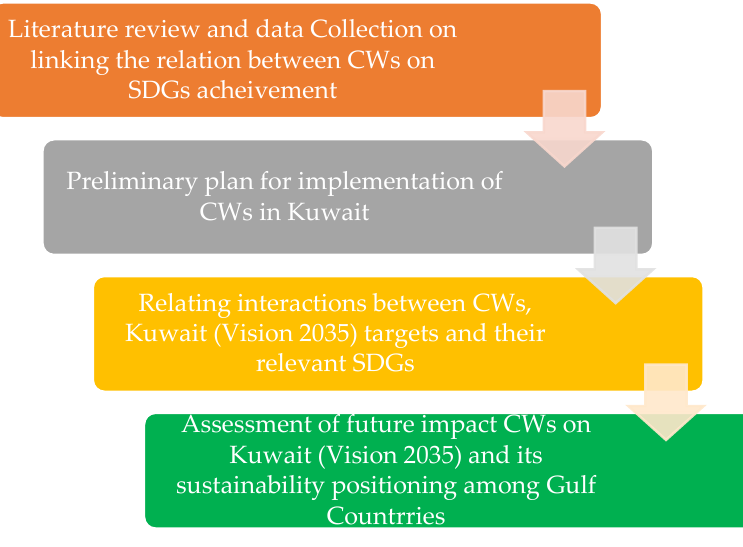
Figure 2. Research methodology.